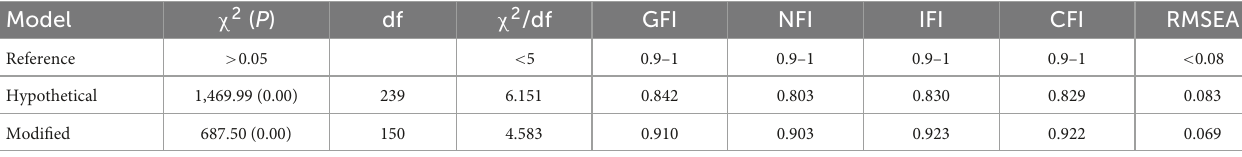
TABLE 4 Comparison of model fit for the modified model to the hypothetical